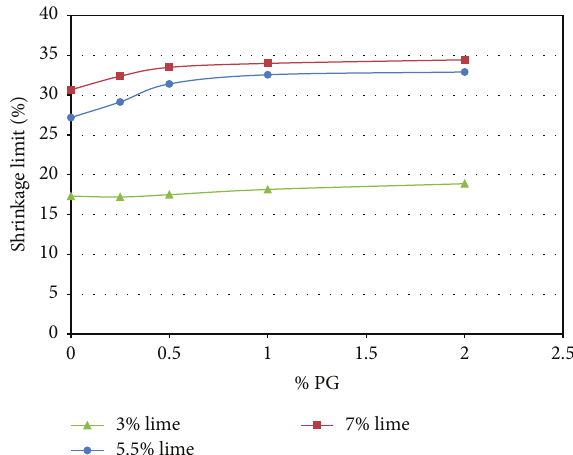
Figure 9: Shrinkage limit of lime stabilized soil admixed with PG.